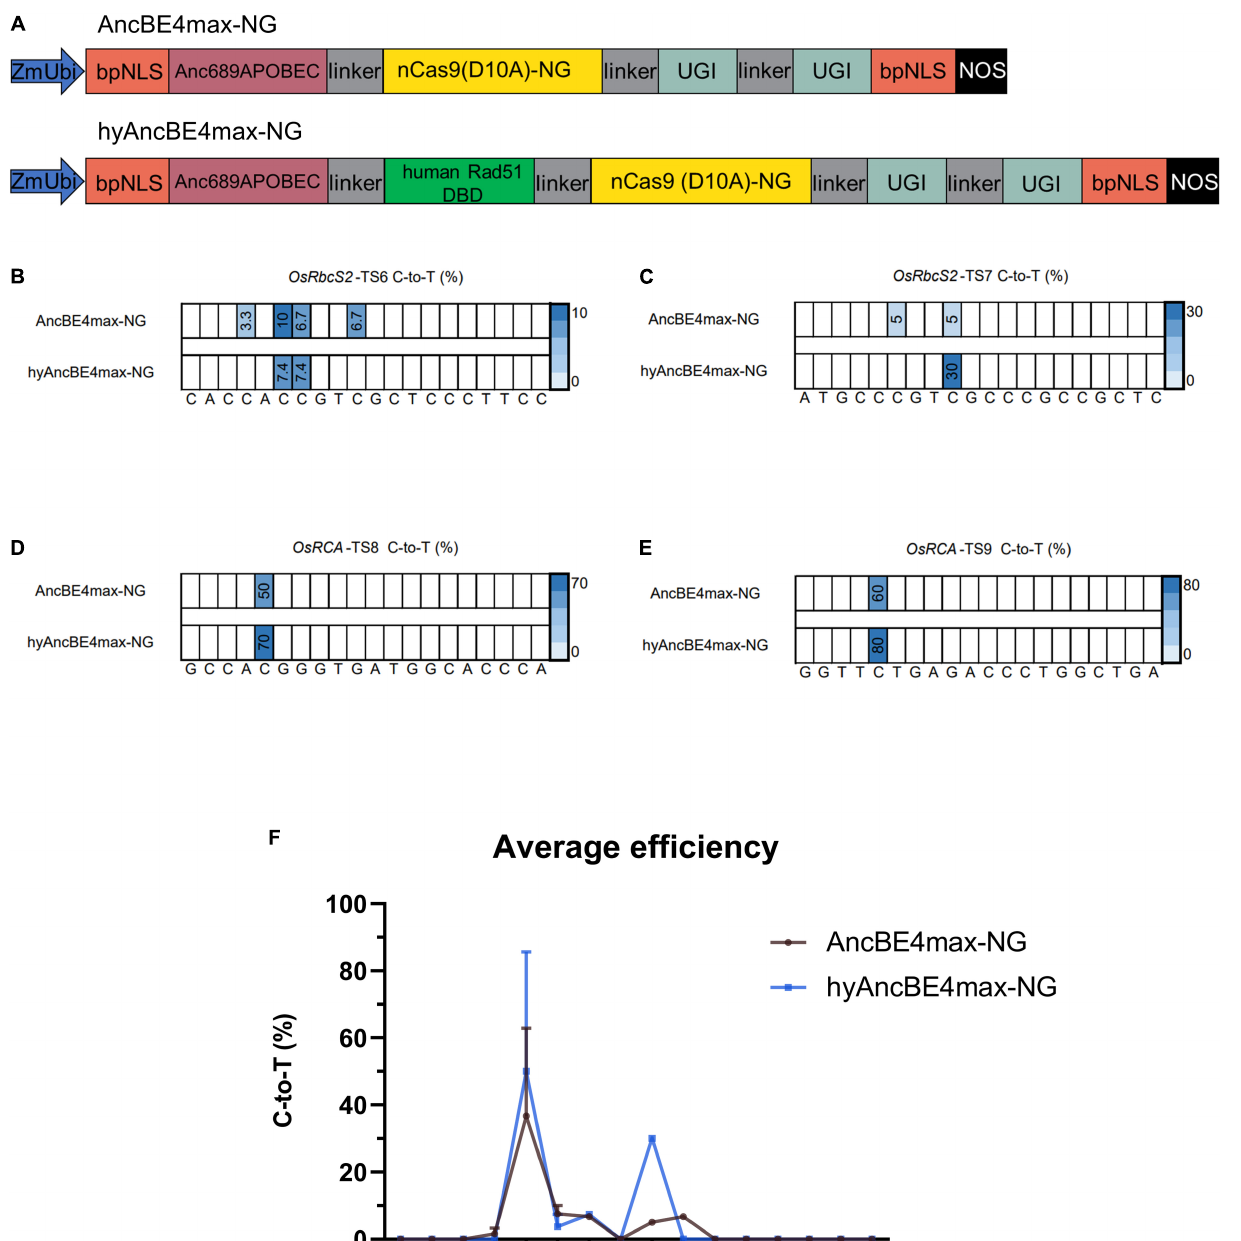
The average incidence of indels for hyAncBE4max-NG and AncBE4max-NG was much lower than that observed in the AncBE4max and hyAncBE4max system, with 2.3% for AncBE4max-NG and 0.93% for hyAncBE4max-NG